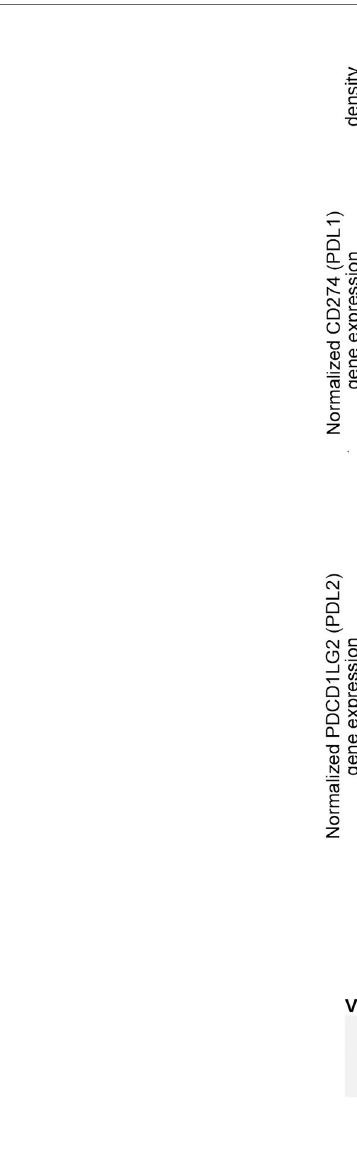
FIGURE 8 | Correlation between CD274/PDCD1LG2 and CD8B expression. Gene expression levels for CD274, PDCD1LG2 and CD8B were normalized using a variance-stabilizing transformation from DESeq2 R package. Pearson ’ s correlation coef fi cients and p-values are shown in the scatter plots, as well as the regression line. The con fi dence interval was inferred using Fisher ’ s Z transform. Point colors are set according to the steroid phenotype: salmon for HSP and blue for LSP. Point shapes are set according to the patient ’ s vital status: triangles for dead and circles for alive. In the rug plot, navy blue indicates the presence of cortisol excess, gray indicates absence, and white indicates non-annotated patients regarding cortisol levels. In the density plot, p-values determined using Wald ’ s test for DE analysis between LSP and HSP is